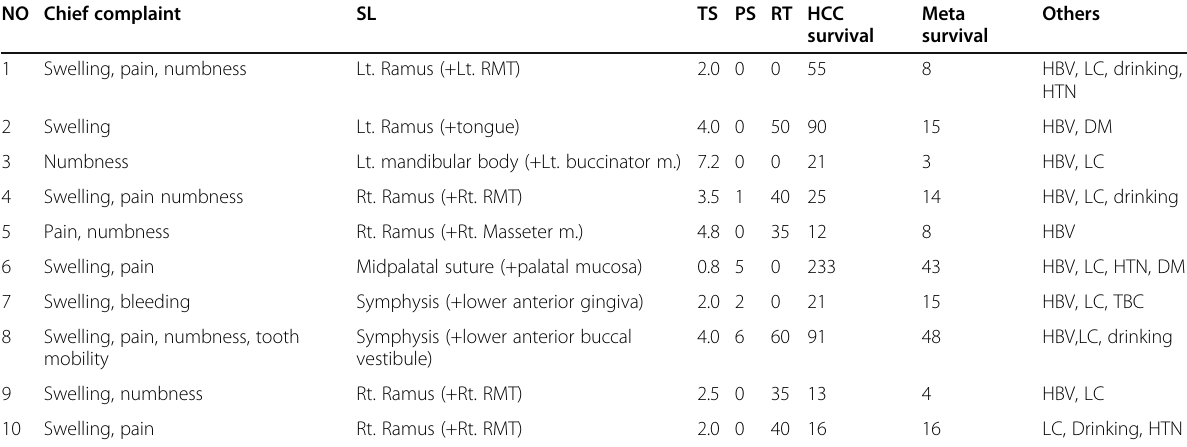
Table 2 Clinical details of the patients with oral metastasis by hepatocellular carcinoma NO Chief